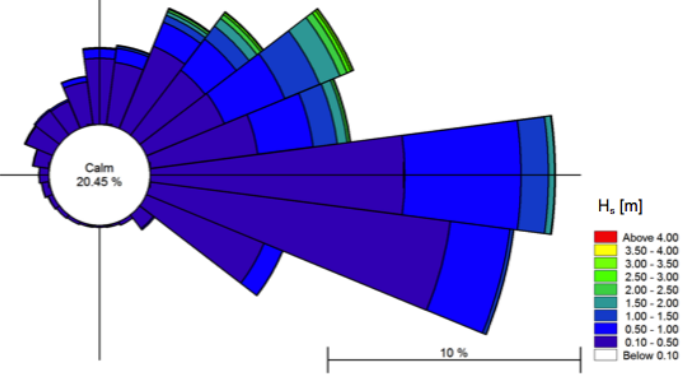
Figure 2. Wave rose at the study area of Lido di Spina from the transposed observations.